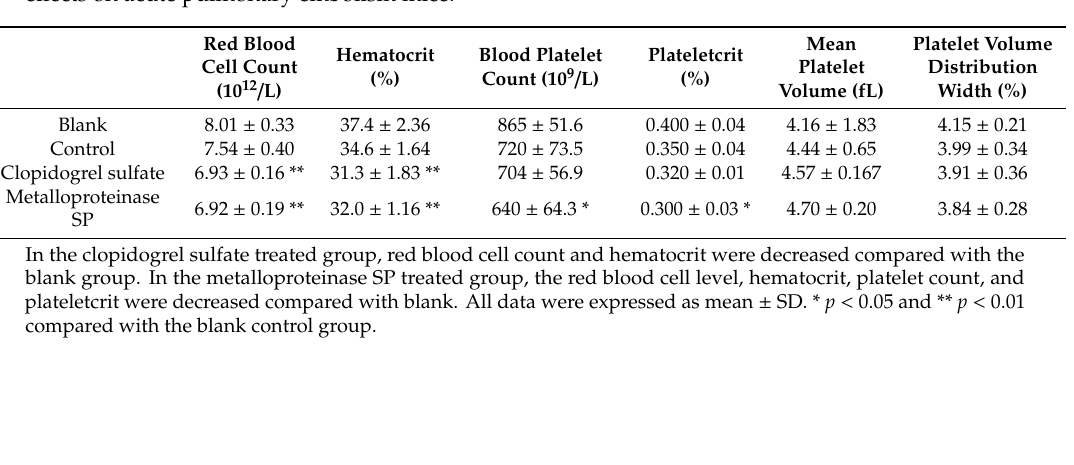
Table 3. Hemodynamic examination of venous blood to check clopidogrel and metalloproteinase SP e ff ects on acute pulmonary embolism